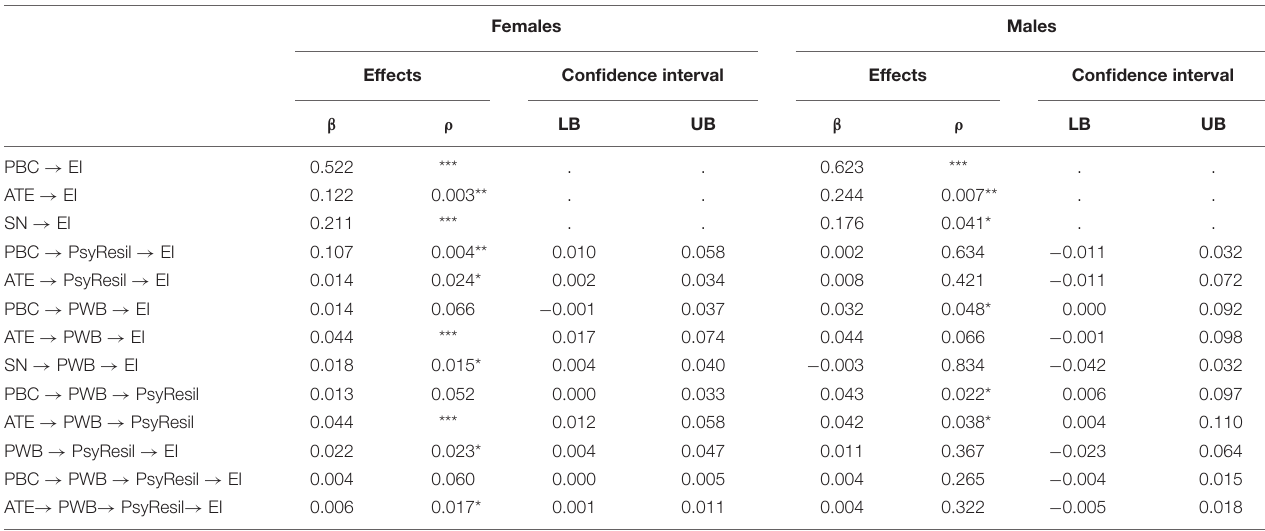
TABLE 5 | Effects for path model by